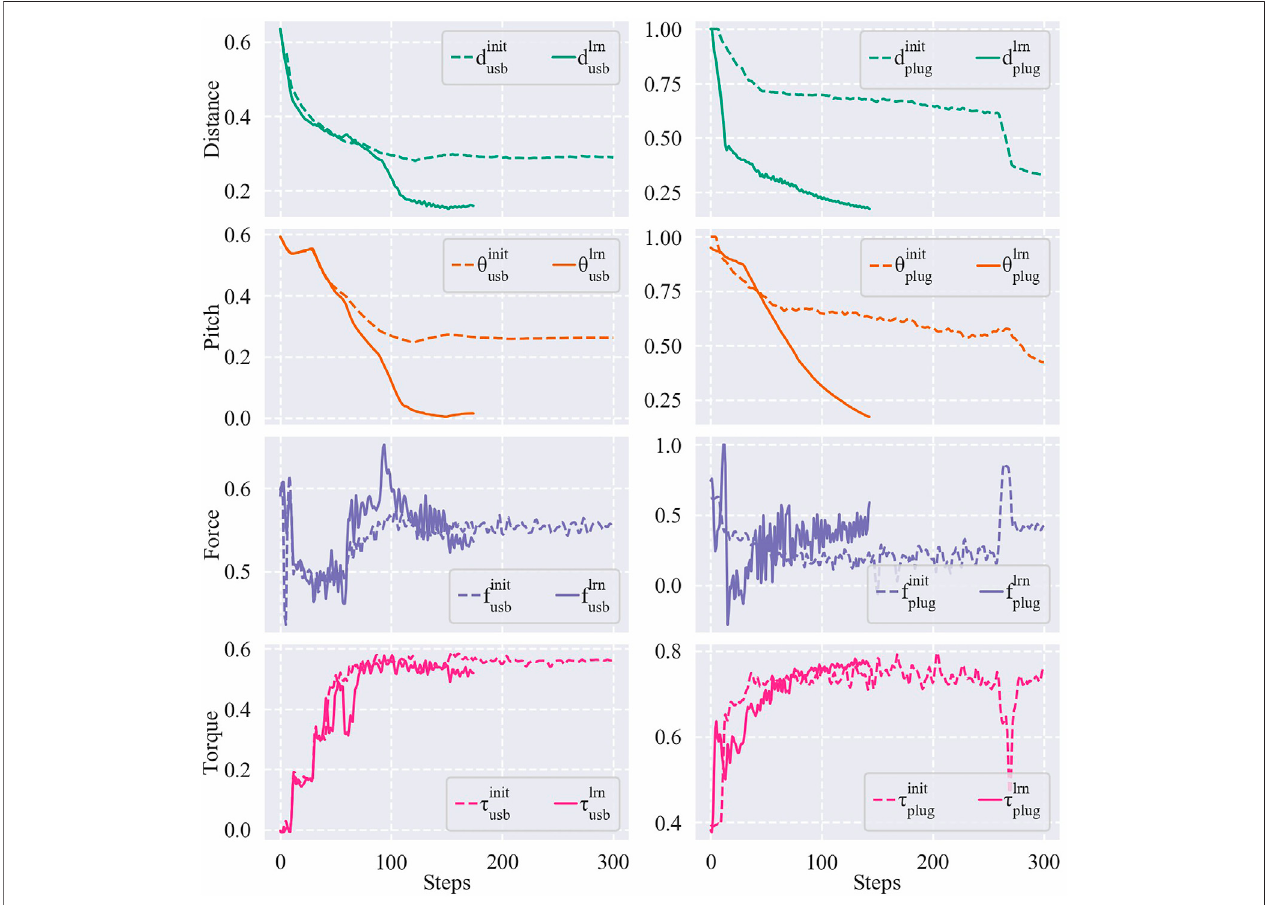
FIGURE 11 | Distance errors, pitch angle errors, and force/torque data of a USB insertion (left) and a plug insertion (right) using their initial/learned policies. The error values have been mapped to a range of [1, 0] and the force/torque values have been mapped to a range of [ − 1, 1].